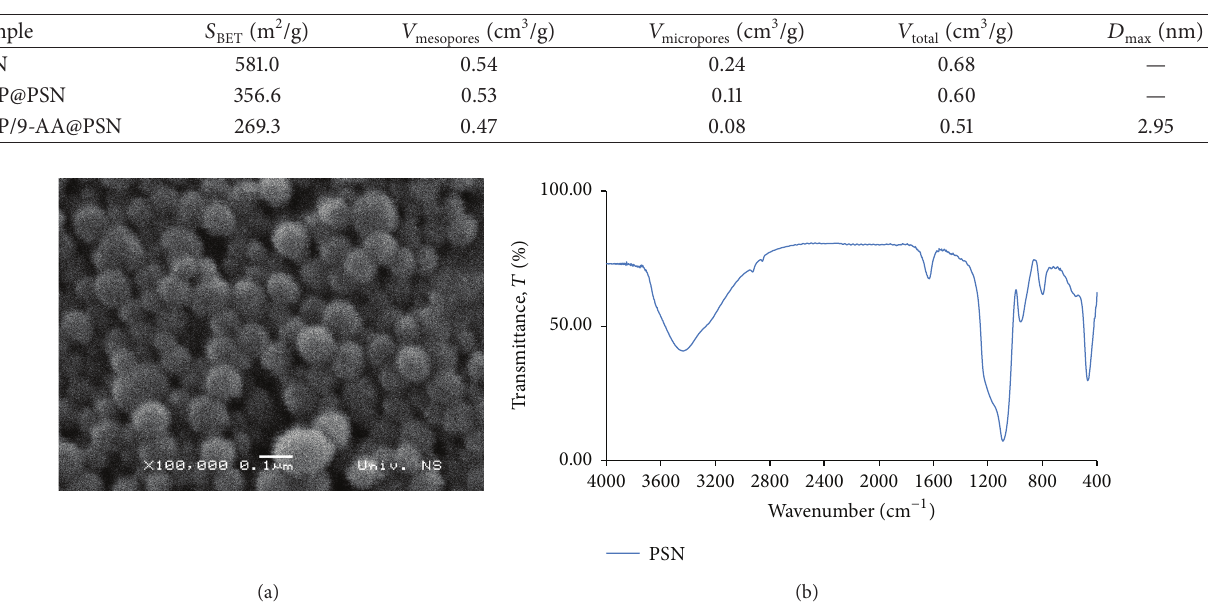
Figure 1: (a) SEM image of FNP/9-AA@PSN material and (b) FTIR spectrum of PSN